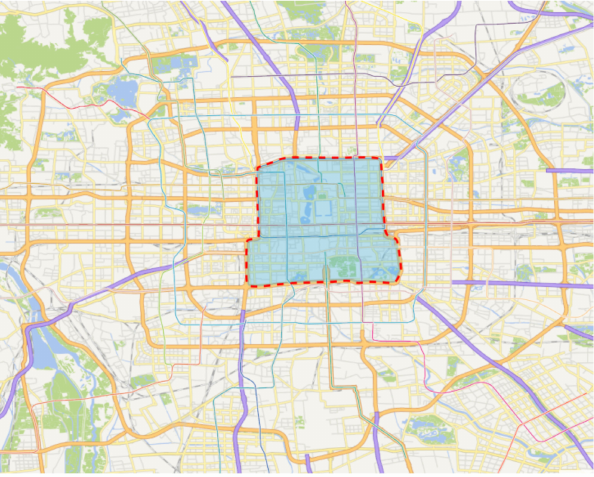
Figure 2. Location of the study area in Beijing (enclosed area of dashed line).